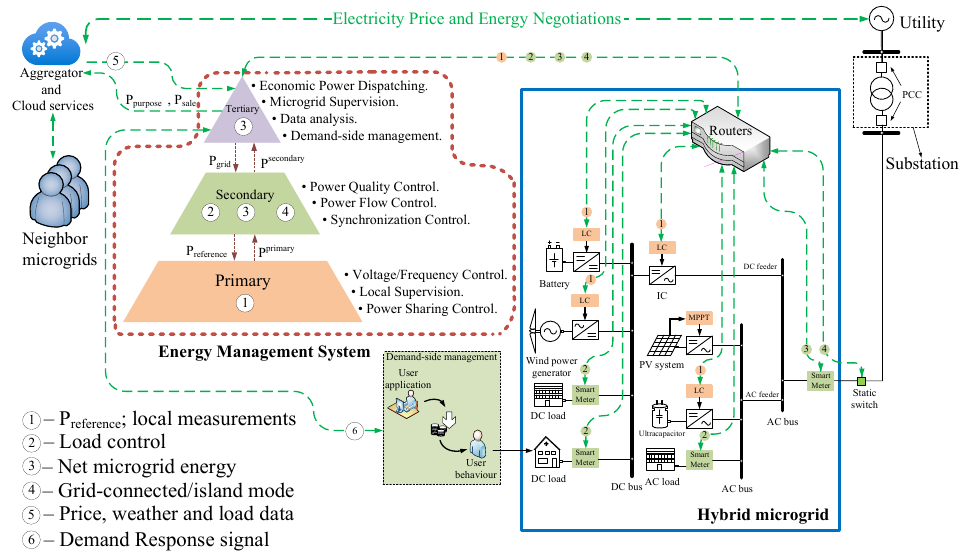
Figure 6. Hierarchical control of AC-DC microgrids in a building.